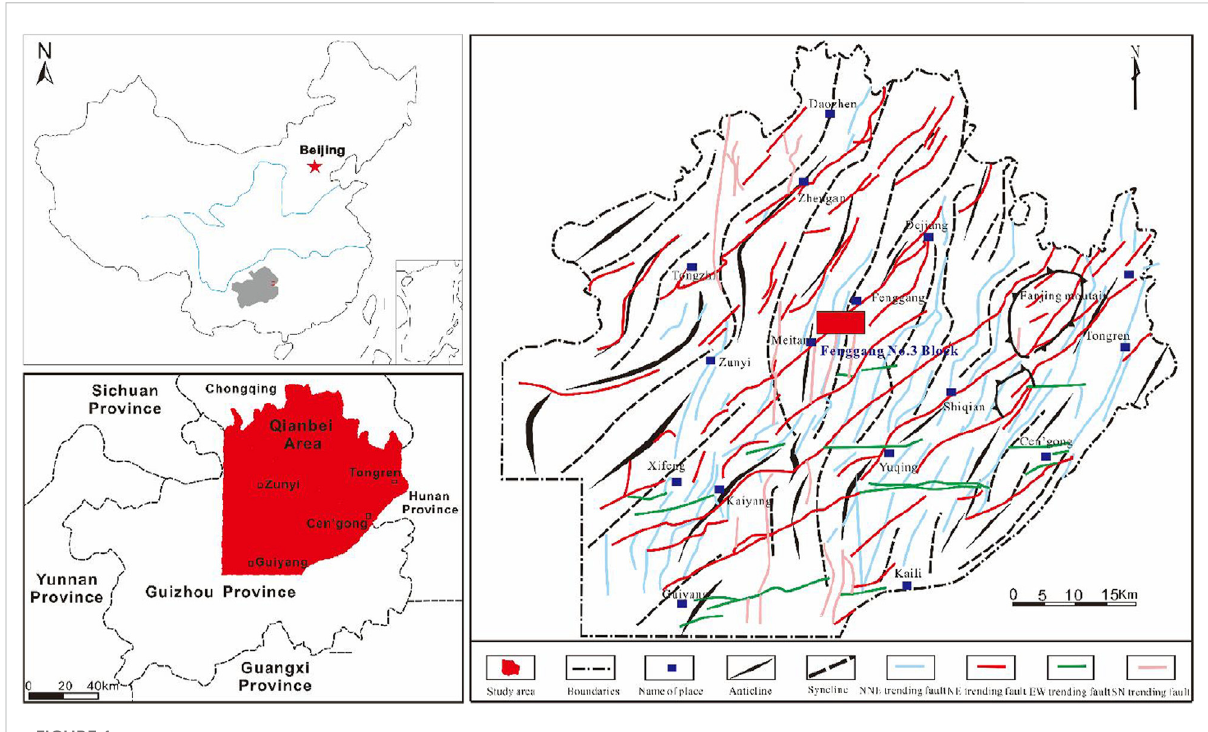
FIGURE 1 Area map of the Fenggang No.3 Block, Qianbei, Guizhou (Liu et al.,